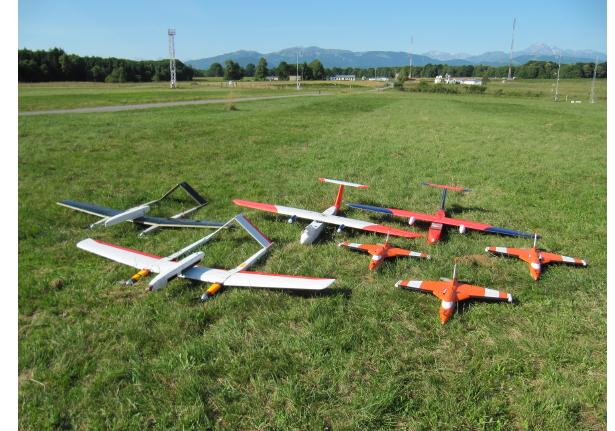
Figure 2. The fleet of RPAS operated during the whole BLLAST campaign at Site 1 in Lannemezan. From left to right: MASC (University of Tübingen), M 2 AV (University of Braunschweig) and SUMO (University of Bergen). In the background the Pyrenees and the Site 1 60m instrumented tower in the upper right